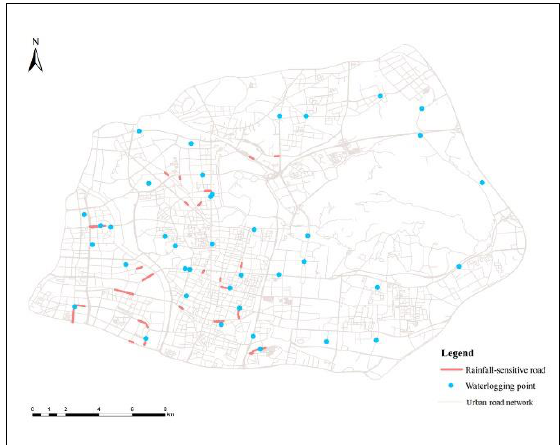
Figure 9 . Spatial distribution of waterlogging points from